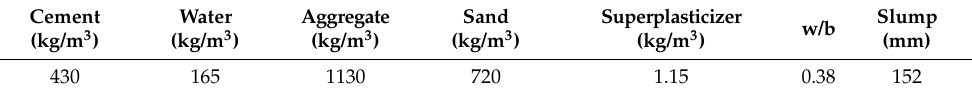
Table 1. Mix proportion of C50 concrete.